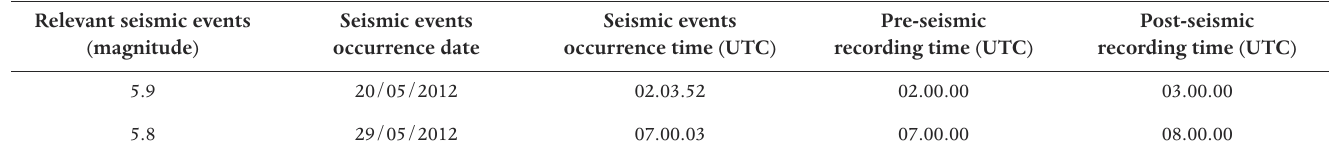
Table 1. Occurrences of the two most relevant seismic events, with the pre and post recording